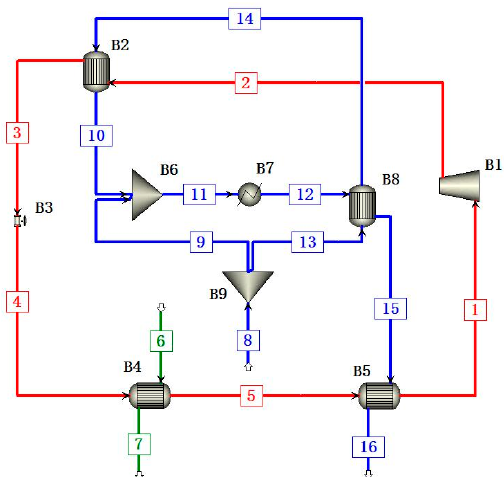
Figure 2. Flow chart of the steady simulation with ASPEN PLUS.